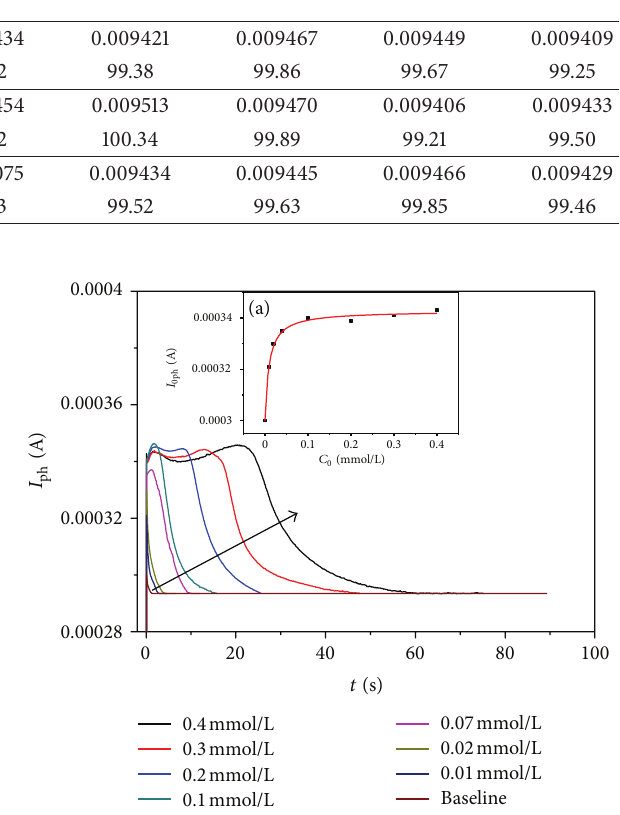
Figure 5: Voltammograms of different concentrations of NaNO 3 blank solution containing benzoic acid (0.4mmol/L) in the thin- cell reactor based on the TNA electrodes under illumination of 7.9mW/cm 2 . Table 3: 𝑄 and degradation efficiency of 0.4 mmol/L benzoic net concentrations under illumination of acid with different NaNO 3 7.9mW/cm 2 and a fixed applied bias voltage of 2.5V. Electrolyte concentration (mol/L)